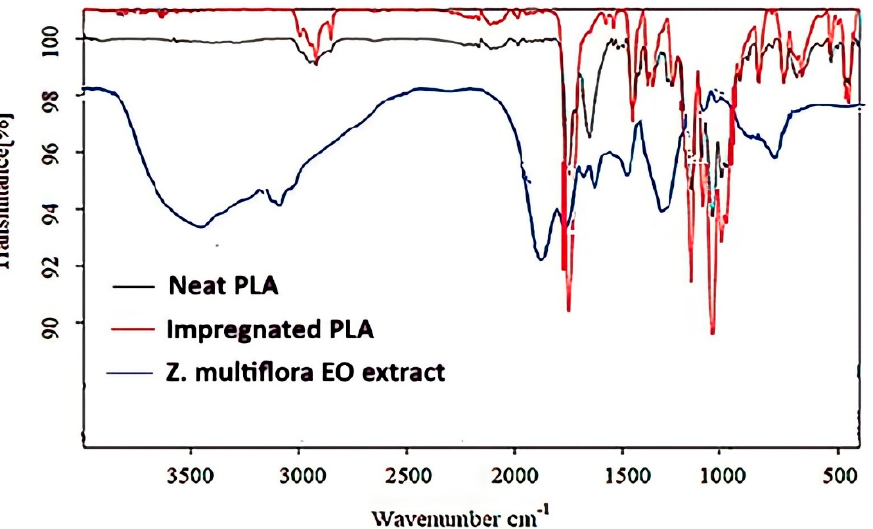
Figure 7. FTIR spectra of neat PLA, impregnated PLA, and Z. multiflora EO extract at the optimum conditions.